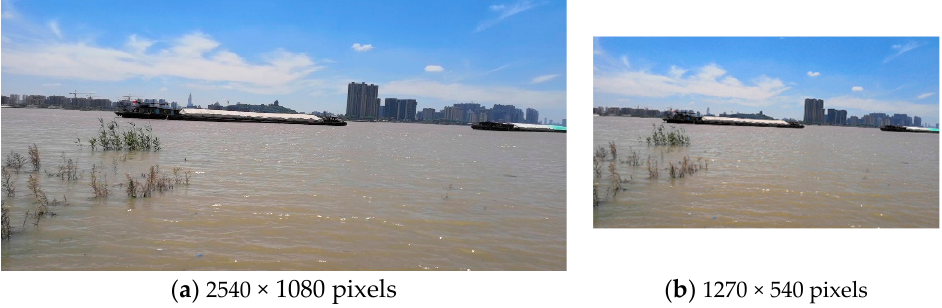
Figure 3. Original image and downscaled image.